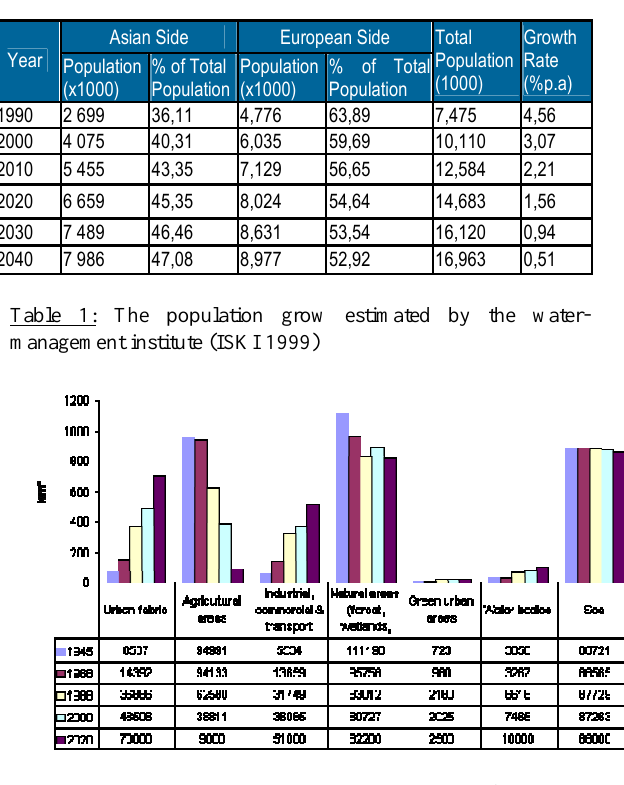
Figure 8: Development up to the year 2020 out of the trend